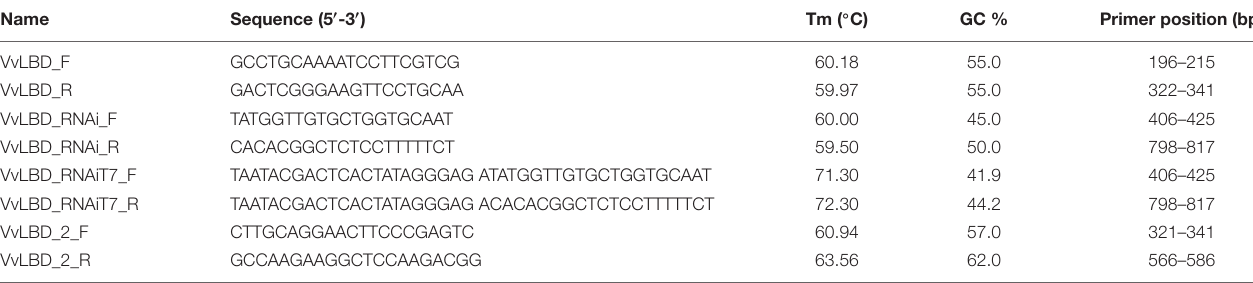
TABLE 1 | List of primers used in this work to synthetize the